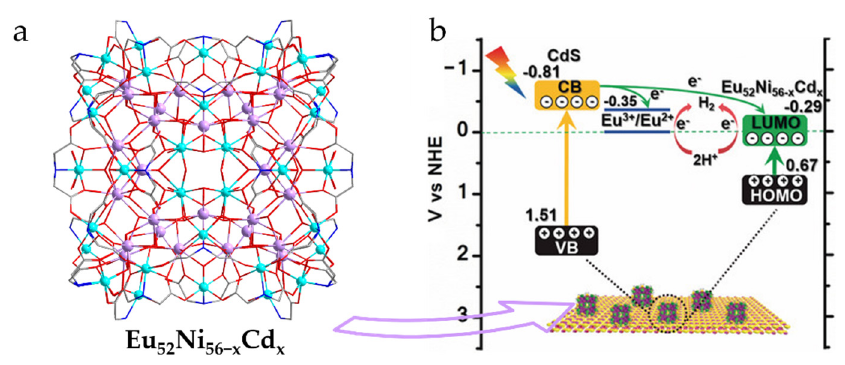
Figure 7. ( a ) The structure of Eu 52 Ni 56 − x Cd x with 20% substitution percentage of Cd 2+ . ( b ) The mechanism of multipath charge separation in HER. Color legends: Ln, lavender; Ni 0.8 Cd 0.2 , turquoise; O, red; C, gray; N, blue. Adapted with permission from Ref. [54]. Copyright 2018, Wiley-VCH.